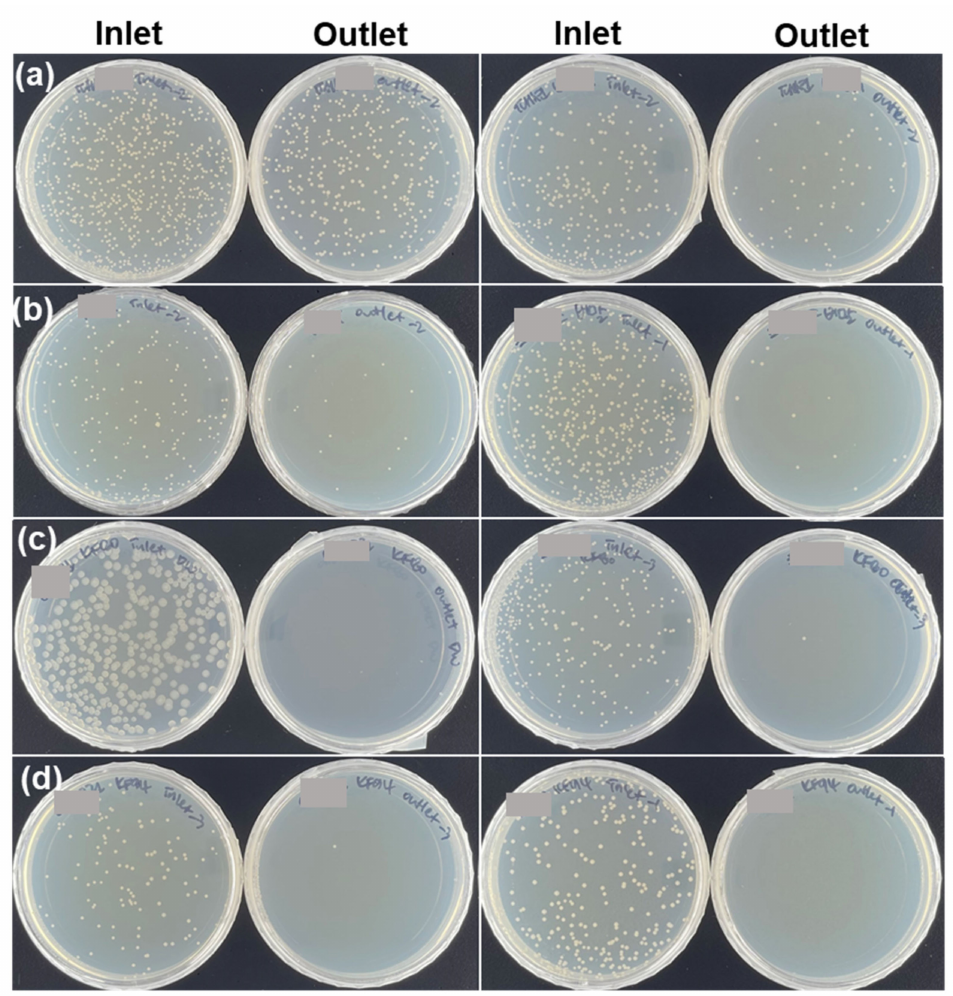
Figure 4. Photographs of collections of airborne bacteria-containing droplets on agar plates that had been placed near the inlet (first and third rows) and outlet (second and fourth rows) of the filtration unit containing ( a ) woven, ( b ) antidroplet, ( c ) KF80, and ( d ) KF94 masks, respectively. Filtered airborne bacteria-containing droplets were found in all of the layers of the KF94 mask, but were mostly filtered in the outer, support, and filter layers (Figure 5). Notably, a pile of particles was attached to the surface of filter fibers. EDS analysis indicated that the particles, having dimensions of 0.3–2.5 µ m, were composed of C, Na, Cl, O, P, and N elements (Figure S4). The elemental mapping images thus demonstrated that the filtered particles contained the elements common in biological creatures such as bacteria and were thus attributable to the airborne bacteria-containing